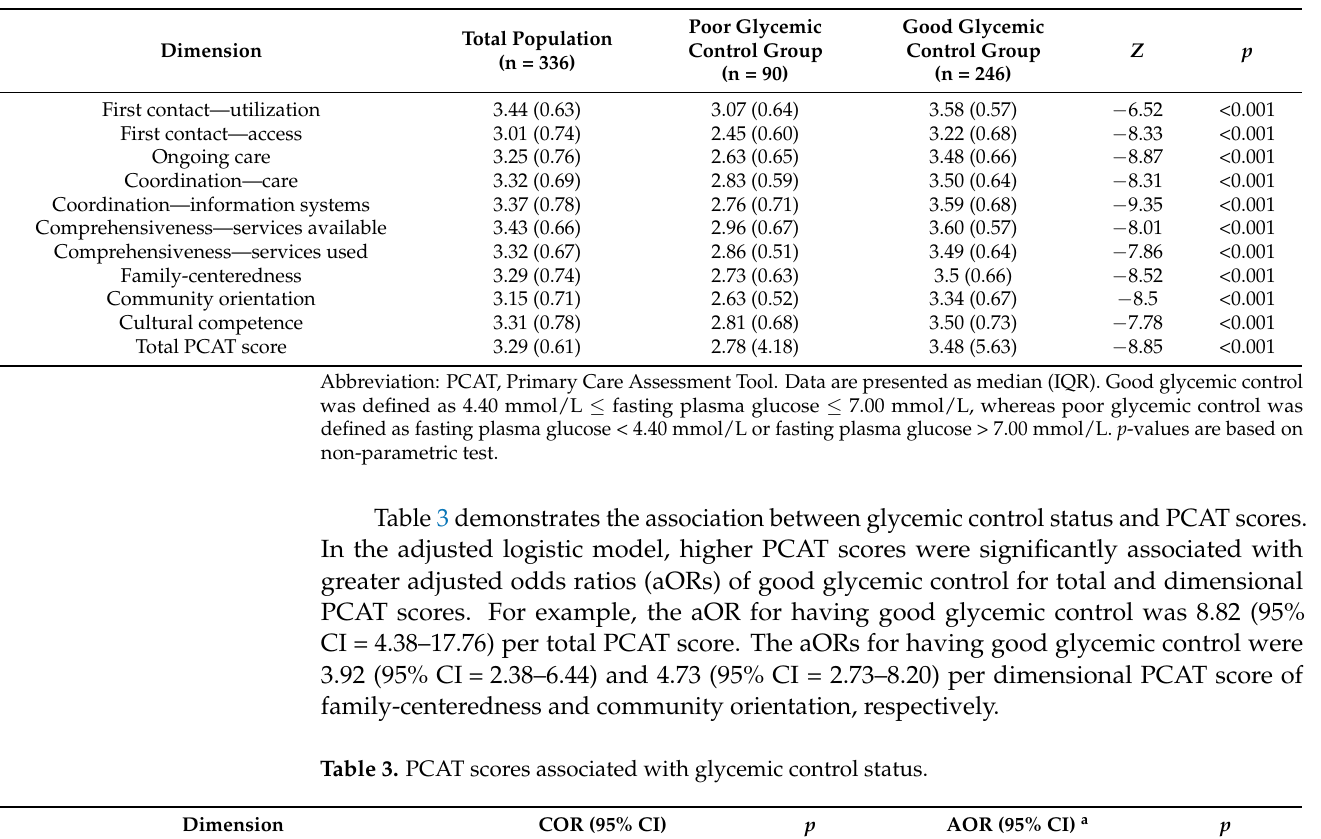
Table 2. PCAT scores stratified by glycemic control status.